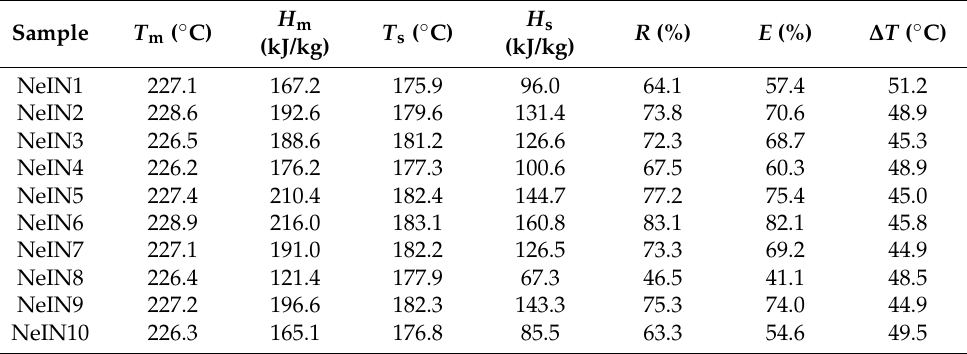
Table 3. Phase-change properties of the